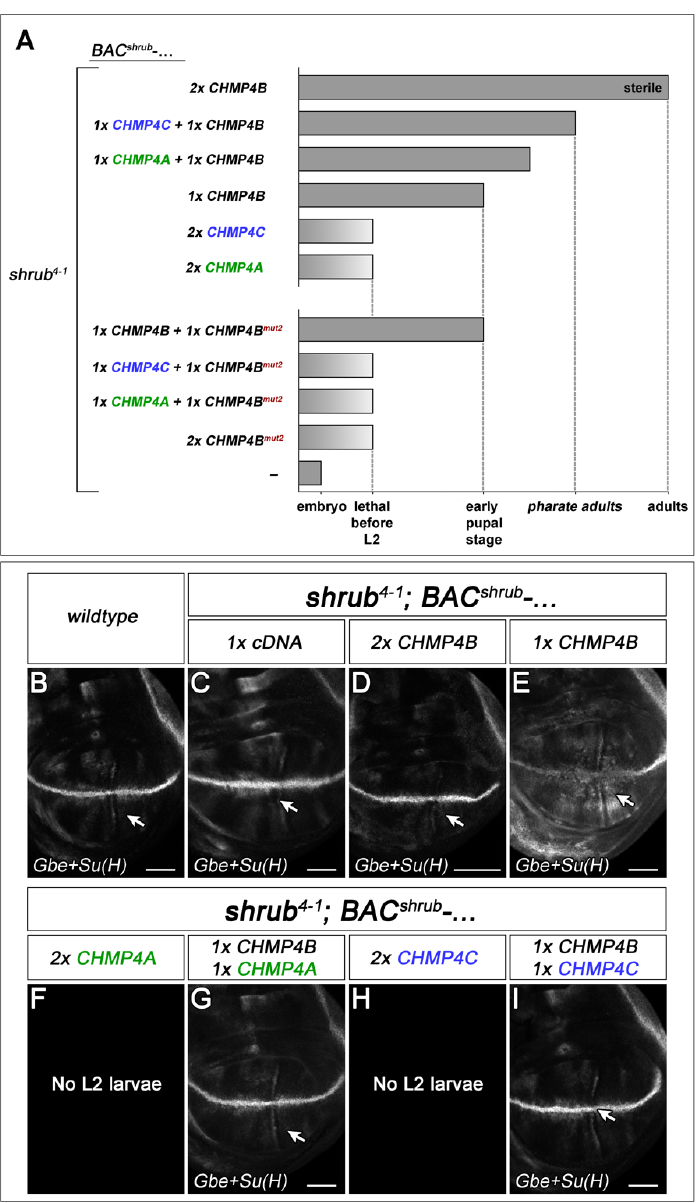
Figure 1. Functionality of human CHMP4 proteins in Drosophila . ( A ) Summary of the rescue experiments of CHMP4 orthologs. In contrast to CHMP4B, CHMP4A and CHMP4C were not able to rescue the shrub mutant phenotype. Nevertheless, they can improve the rescue of one copy of CHMP4B. The here ‐ depicted CHMP4 mut2 is a variant bearing three charge reversal mutations (E90R, E94R, and E97R) in its negatively charged interaction surface that abolish the interactions between CHMP4B protomers [4]. ( B – I ) Expression of the Notch activity reporter Gbe+Su(H) in shrub mutant disc rescued by the CHMP4 orthologs. In contrast to the control construct BAC shrub ‐ cDNA ( C ), one copy of BAC shrub ‐ CHMP4B ( E ) only partially rescues the shrub mutant phenotype, indicated by the weak ectopic expression of Gbe+Su(H) highlighted by the arrow in ( E ). In the case of BAC shrub ‐ cDNA the transcription unit of BAC shrub is replaced by the cDNA of shrub instead of the cDNA of one of the CHMP4 orthologs [3]. ( D ) Two copies of CHMP4B result in a complete rescue, indicated by the pattern of Gbe+Su(H) (compare with B, wildtype). ( F , H ) Even in two copies CHMP4A and CHMP4C were not able to rescue the shrub mutant phenotype. ( G , I ) However, they improve the partial rescue by one copy of CHMP4B leading to a normalisation of the Notch activity. Scale bars ( B – I ) 200 μ m. At least ten wing imaginal discs were analysed for each genotype.